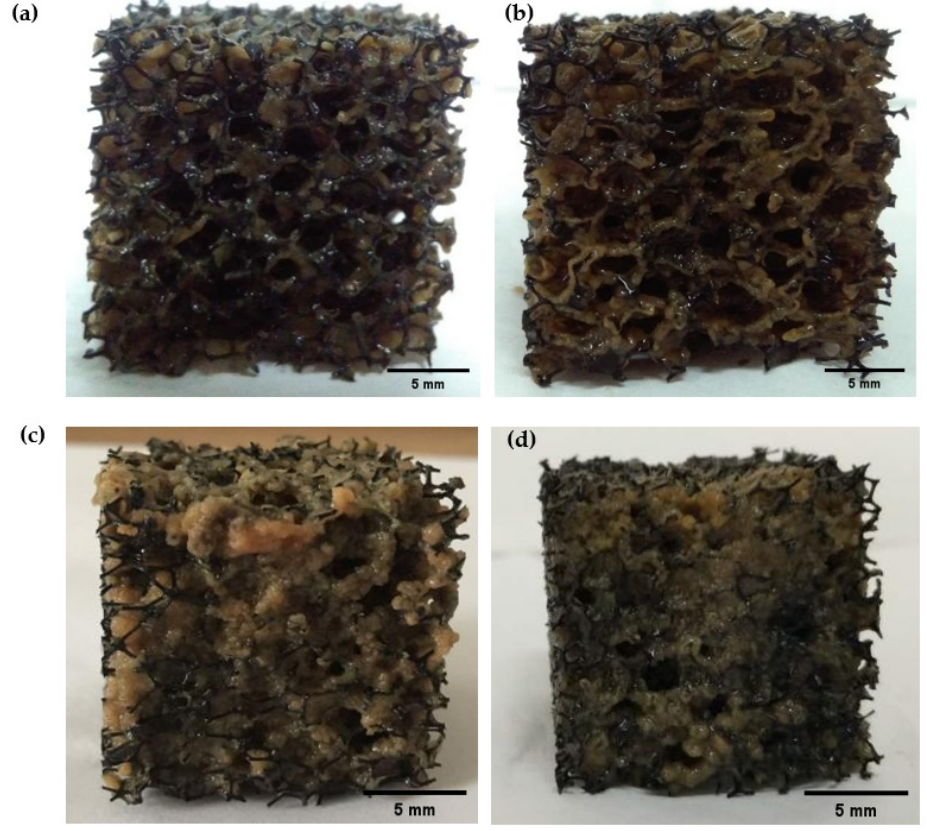
Figure 4. Photos of biofilms grown onto bio-carriers under four scenarios: ( a ) R1; ( b ) R2; ( c ) R3; ( d ) R4. (Scale bars: 5 mm).